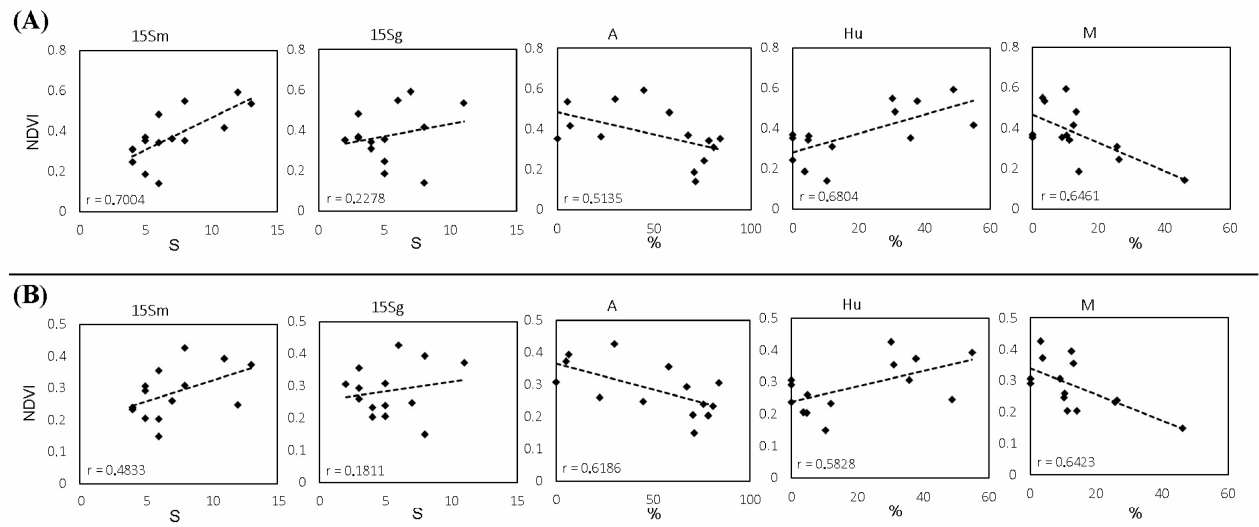
Figure 8. Linear regression analysis. ( A ) Sentinel-2 NDVI (4 August) and ( B ) Landsat-8 NDVI (12 July). S: yeast species richness in musts (15Sm) and grapes (15Sg) from 2015; %: yeast frequency as a percentage of the total species (A, Aureobasidium spp. in grapes; Hu, Hanseniaspora uvarum in musts; M, Metschnikowia spp. in